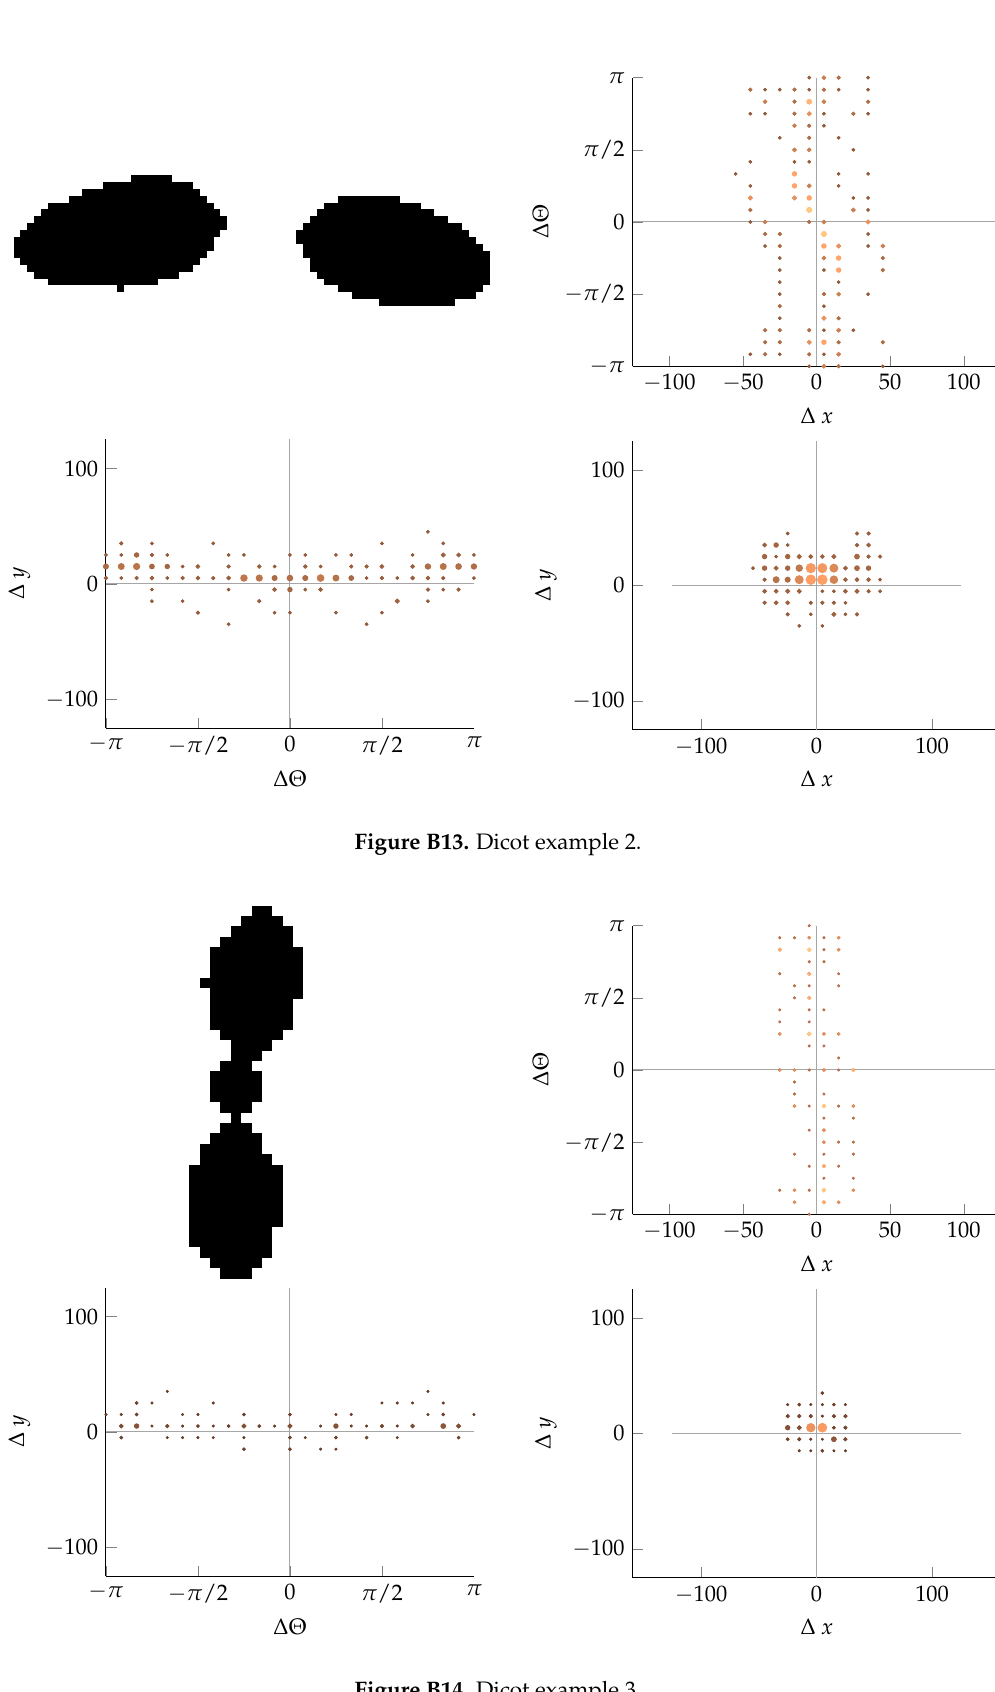
Figure B14. Dicot example